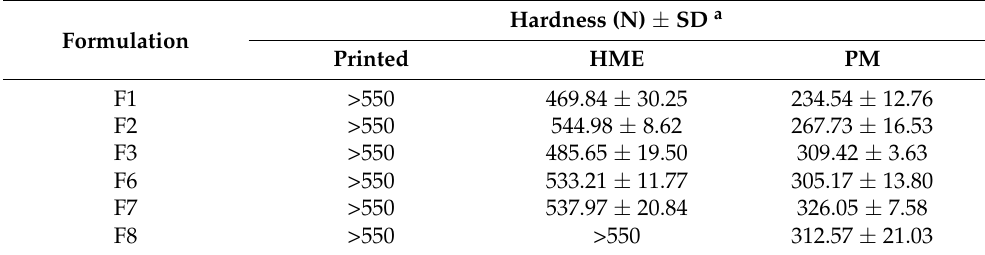
Table 5. Hardness of tablets made via different techniques.